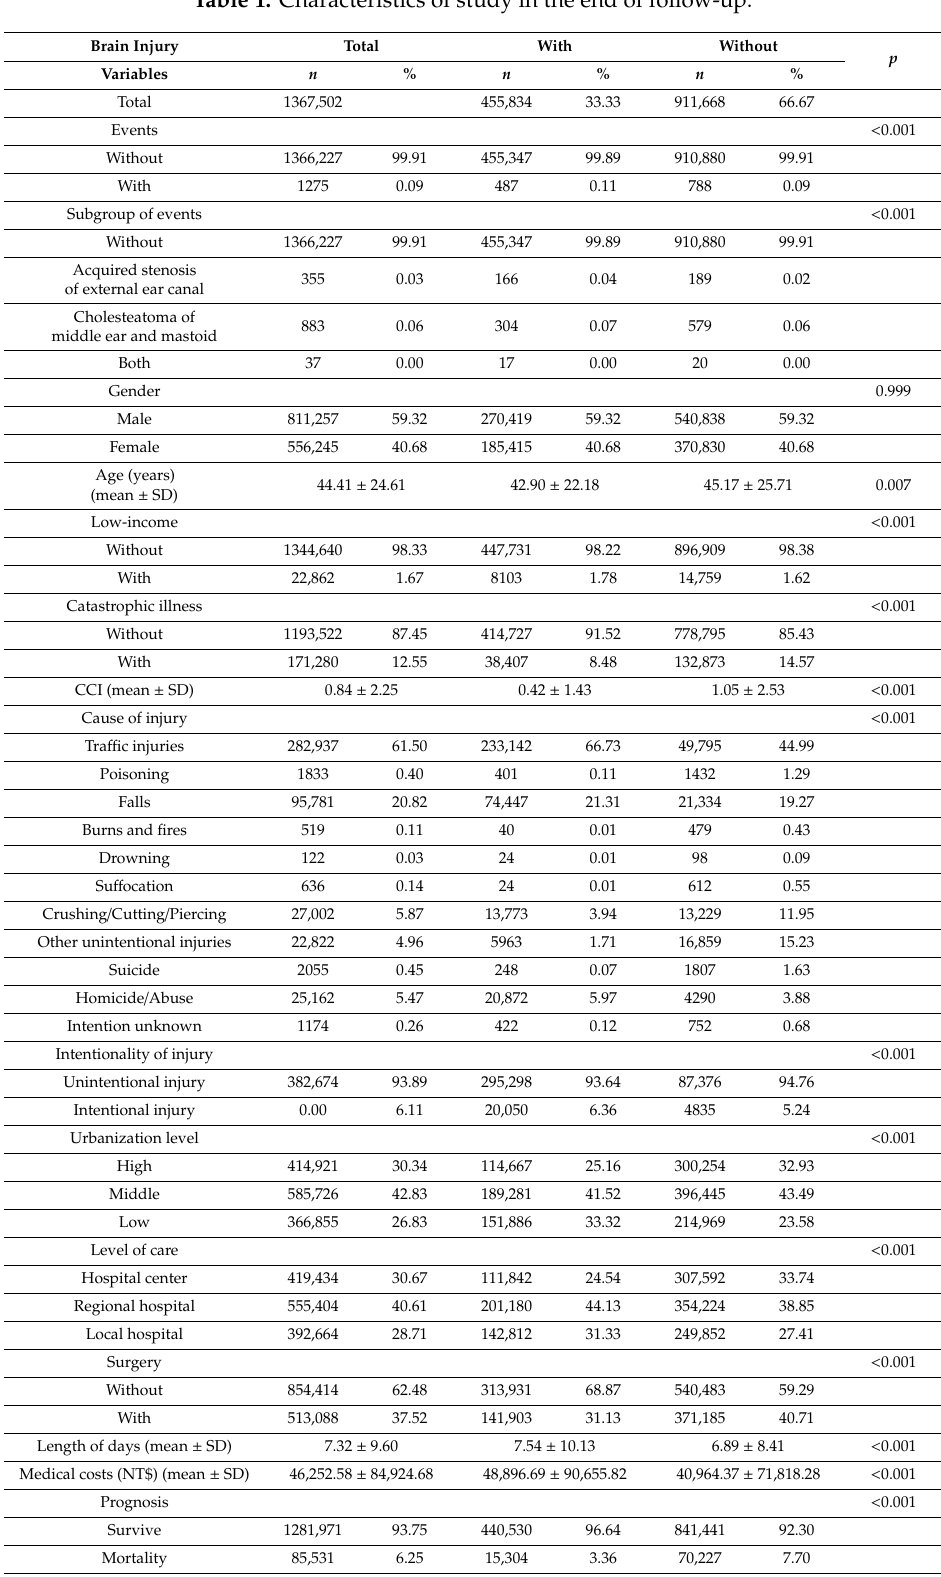
Table 1. Characteristics of study in the end of